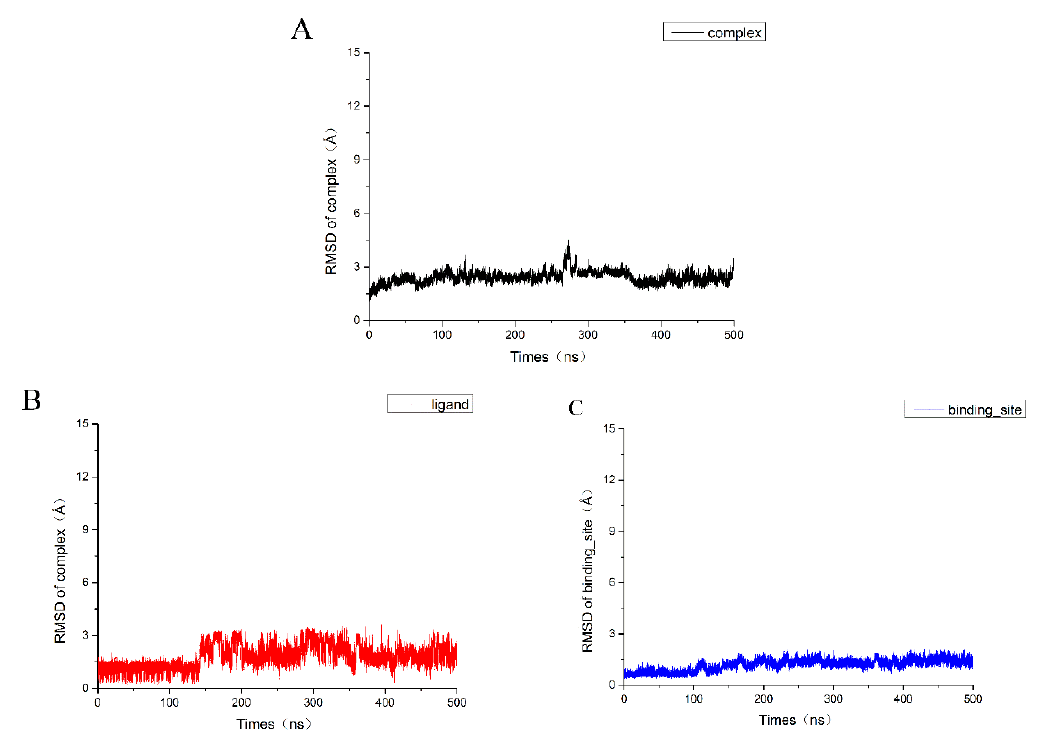
Figure 9. Root mean square deviation (RMSD) of the system. ( A ) the RMSD of the protein backbone atoms of the complex;